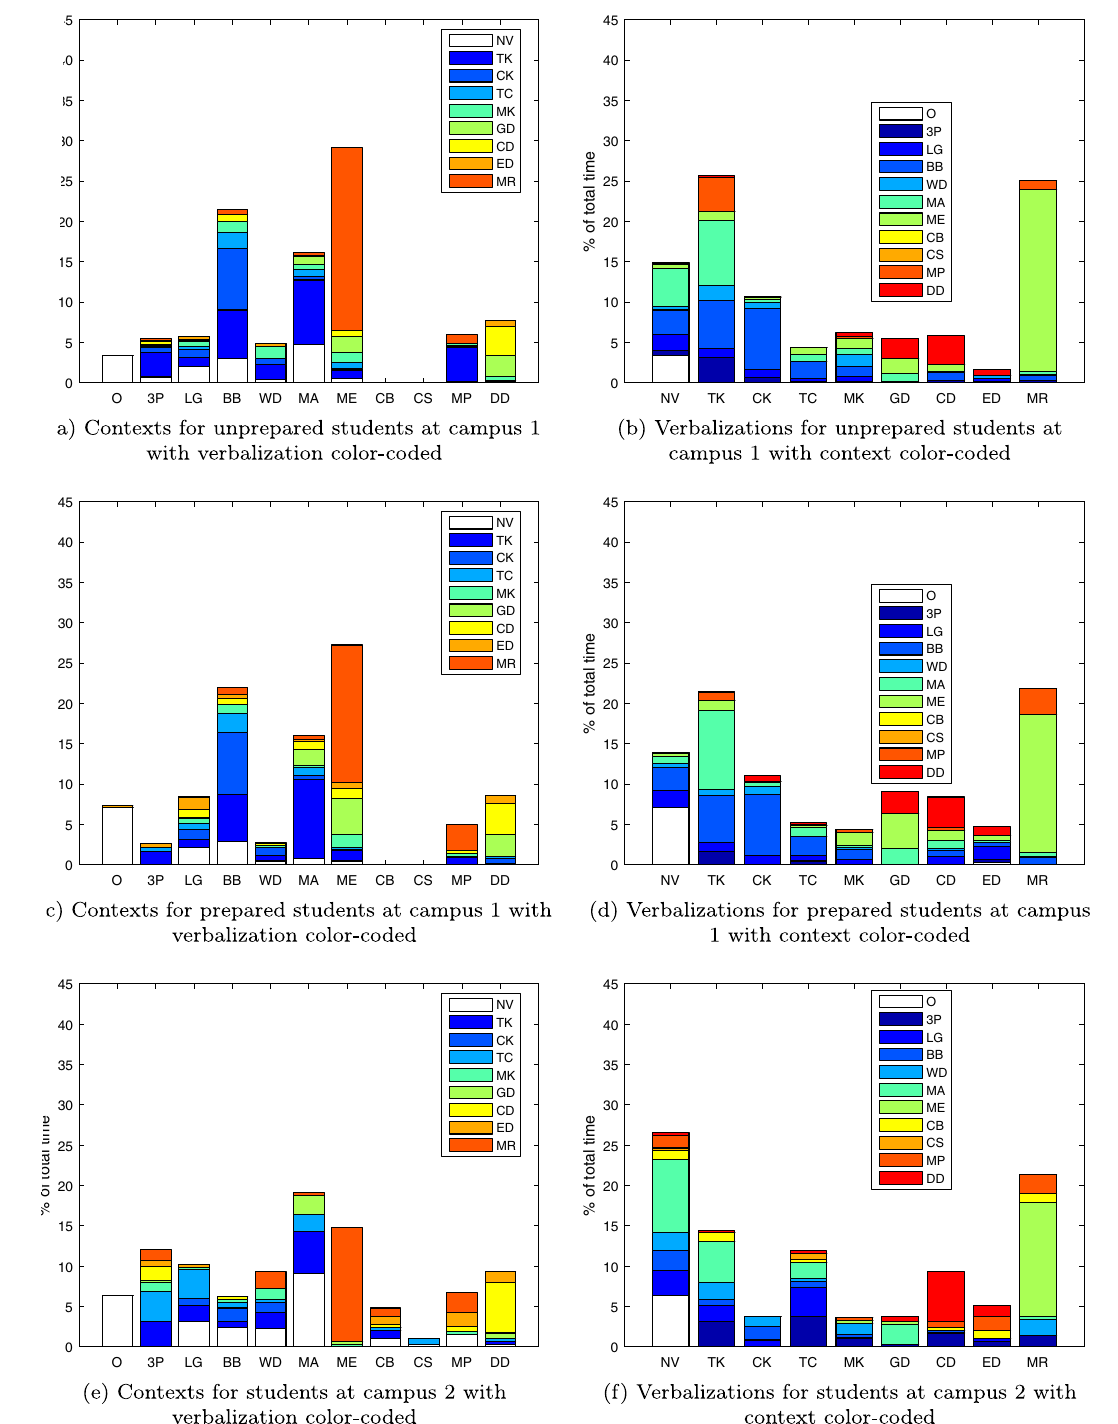
FIG. 6. Results of pilot labs. All percentages are the total of all pairs at the different campuses. Left are contexts in bins with verbalization marked by colors (a), (c), and (e), while right are verbalizations in bins with the contexts marked by colors (b), (d), (f). The first and second row are, respectively, the unprepared (a) and (b) and prepared (c) and (d) students of campus 1, while the (prepared) students of campus 2 are on the third row (e) and